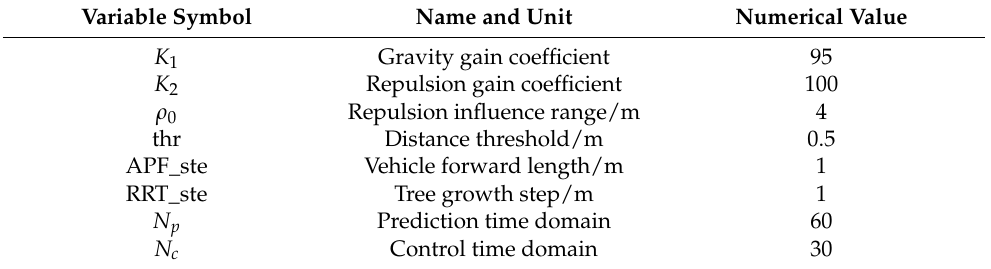
Table 1. Experimental